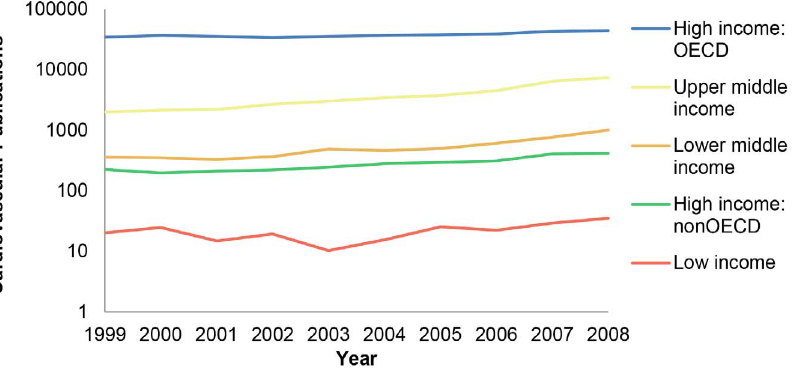
Figure 1. Cardiovascular publications by integer count, by World Bank Income Group (log). Trends in log number of cardiovascular publications by integer count, stratified by World Bank income group (1999–2008).